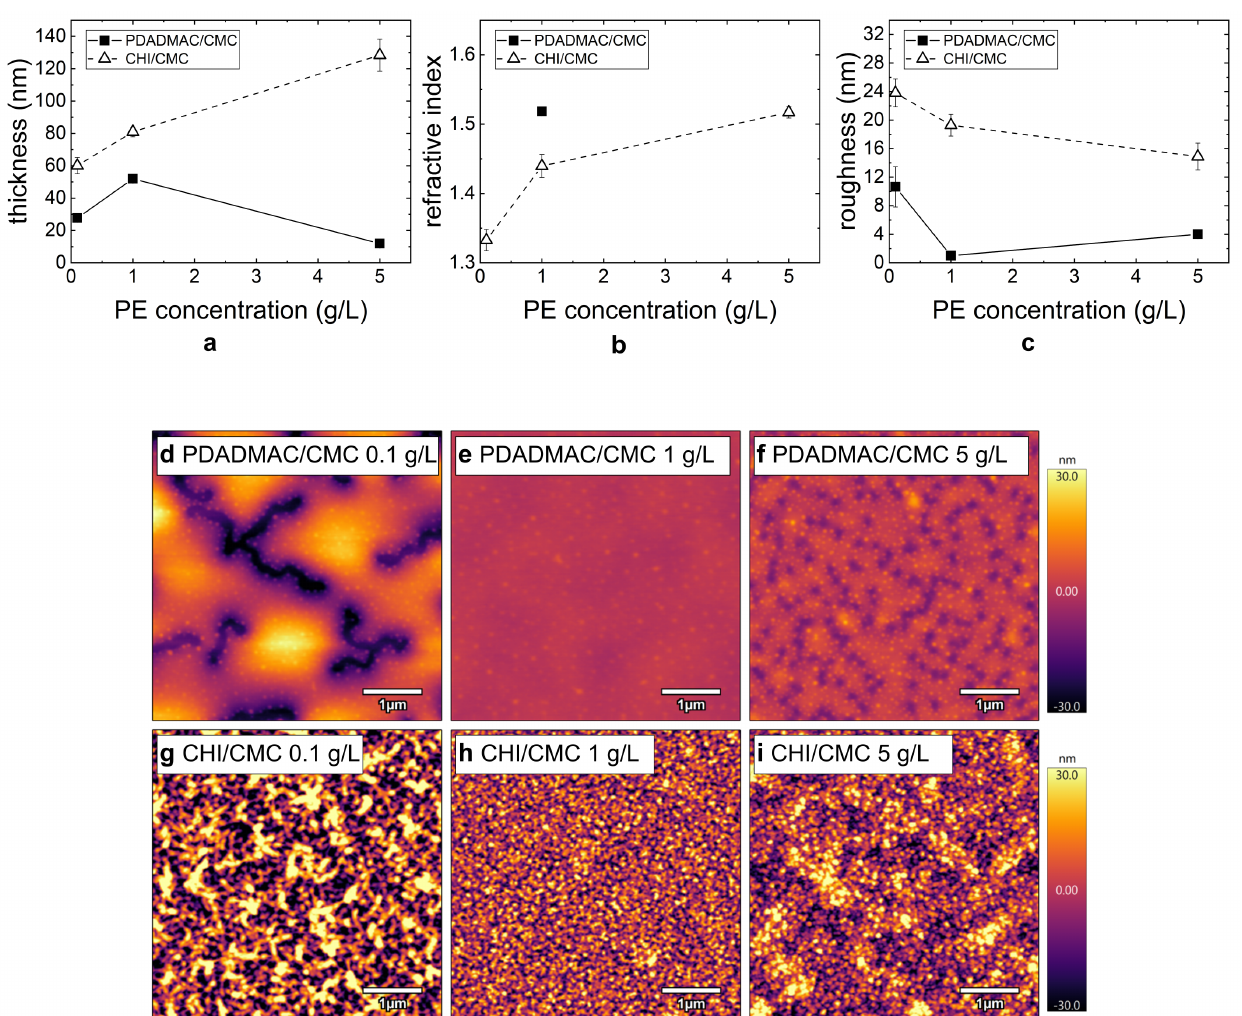
Figure 5. ( a , b ) Change in thickness and refractive index for PDADMAC/CMC (filled squares) and CHI/CMC (empty triangles) with varying PE concentrations determined by ellipsometry (RH ≈ 40%). ( c ) Change in roughness, determined by AFM (RH ≈ 40%), with varying PE concentrations for PDADMAC/CMC (filled squares) and CHI/CMC (empty triangles). ( d – i ) AFM images (5 × 5 µm 2 ) for PDADMAC/CMC and CHI/CMC with varying PE concentrations. For all images, the height scale is set to 60nm. The NoBL was set to seven, and the concentration of all solutions was set to 1g/L. The first bilayer corresponds to the bilayer of the precoat PEI and